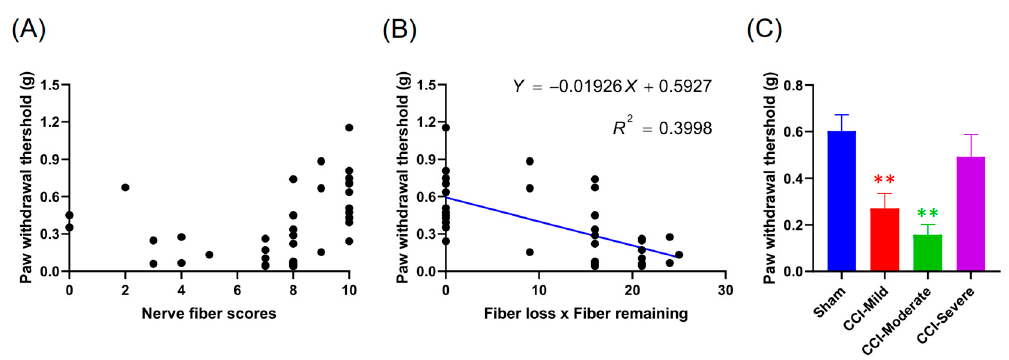
Figure 6. The estimative effect of the correlation between the product of the nerve score test at 7 d and the mechanical threshold at 14 d. ( A , B ) Scatter plots showed that nerve fiber condition at 7 d was significantly correlated with the mechanical threshold tested at 14 d ( p < 0.001). ( C ) The CCI-injured mice were divided into three subgroups according to nerve score. Both the CCI-mild and the CCI-moderate groups but not the CCI-severe group, showed mechanical hypersensitivity. ** p < 0.01, compared to the sham group.